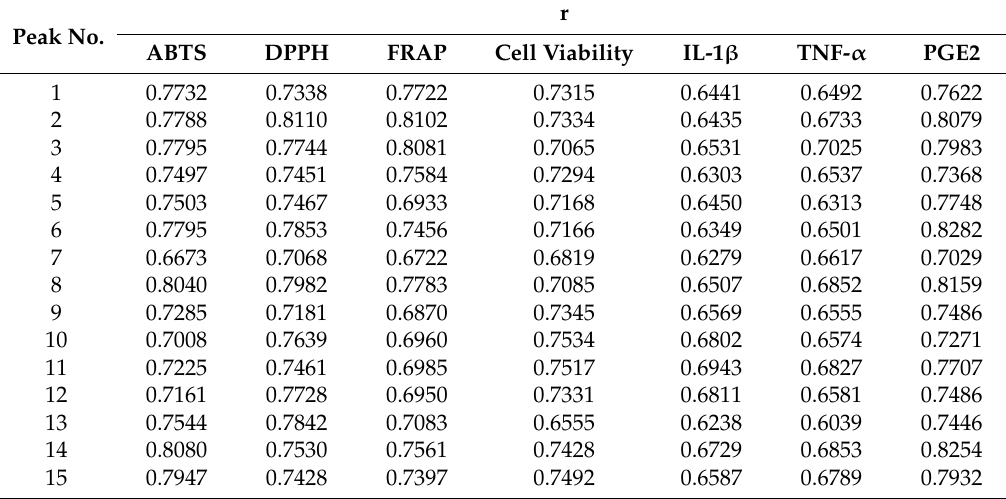
Table 8. The correlation coefficient between the common characteristic peaks and the efficacy of collagen